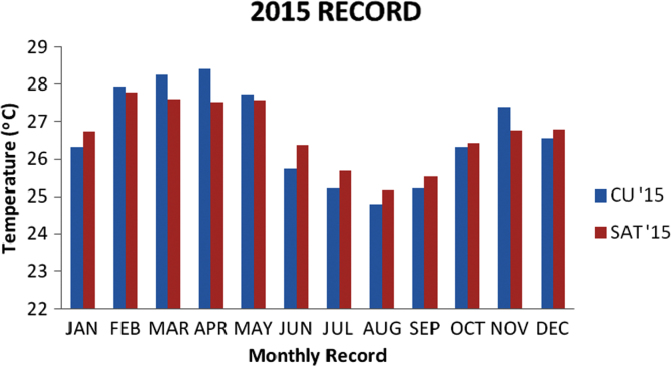
Chart for 2015 Data.